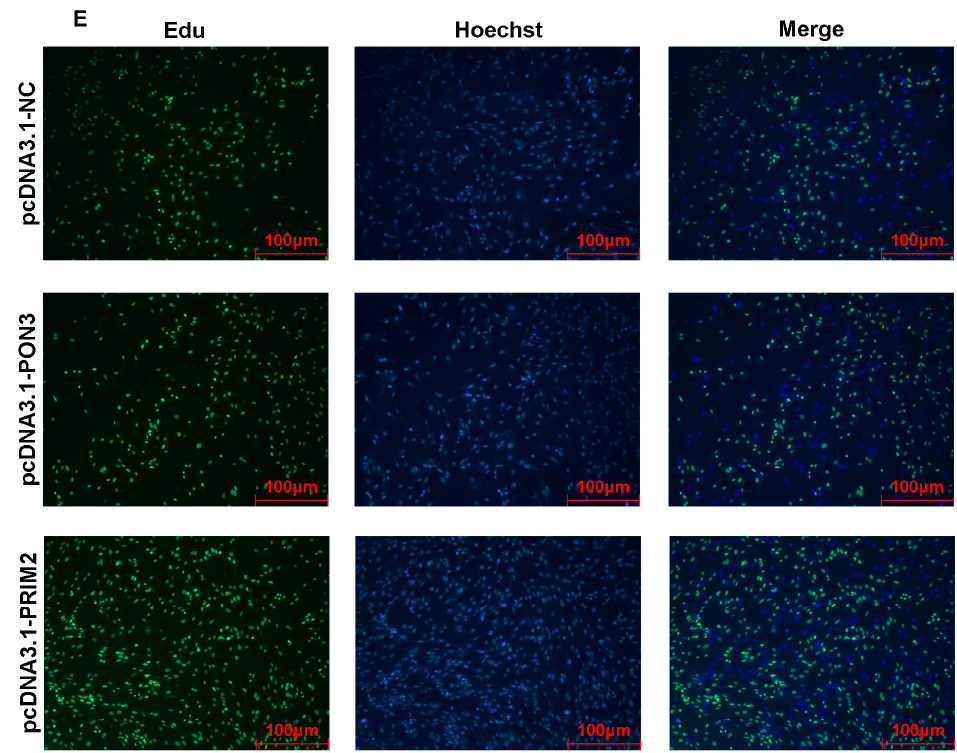
Figure 5. The effect of PON3 and PRIM2 on BSC proliferation. ( A ) The mRNA expression level of PON3 , MYOD , MYOG and AKT when transfected with pcDNA3.1-PON3. GAPDH was used as the reference gene. ( B ) The mRNA expression level of PRIM2 , MYOD , MYOG and SLC7A11 when transfected with pcDNA3.1-PRIM2. GAPDH was used as the reference gene. ( C ) Cell Counting Kit-8 (CCK8) assay showing that overexpressed PON3 promoted BSC proliferation. ( D ) Cell Counting Kit-8 (CCK8) assay showing that overexpressed PRIM2 promoted BSC proliferation. ( E ) EdU staining of the BSCs after the transfection of pcDNA3.1-PON3 and pcDNA3.1-PRIM2. * p < 0.05, ** p < 0.01 and *** p < 0.001.